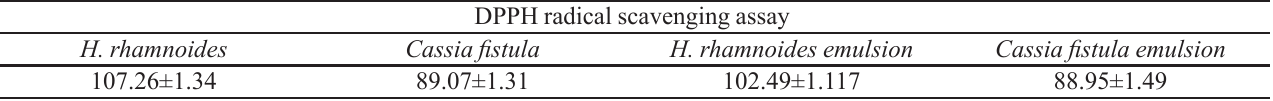
TABLE III - In vitro antioxidant activity (IC